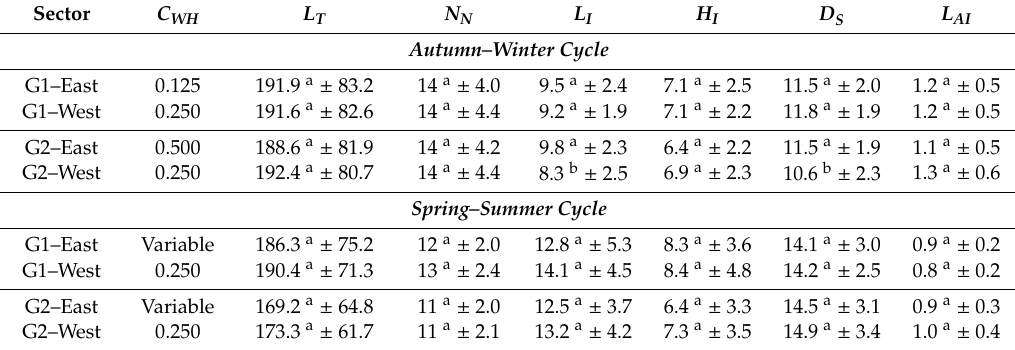
Table 5. Mean ( ± standard deviation) morphological parameters of the plants in both growing cycles in sectors with di ff erent whitening concentration C WH (kg L − 1 ): Total length of the plant L T (cm), number of nodes per plant N N , length of the lowest internode L I (cm), length of the highest internode H I